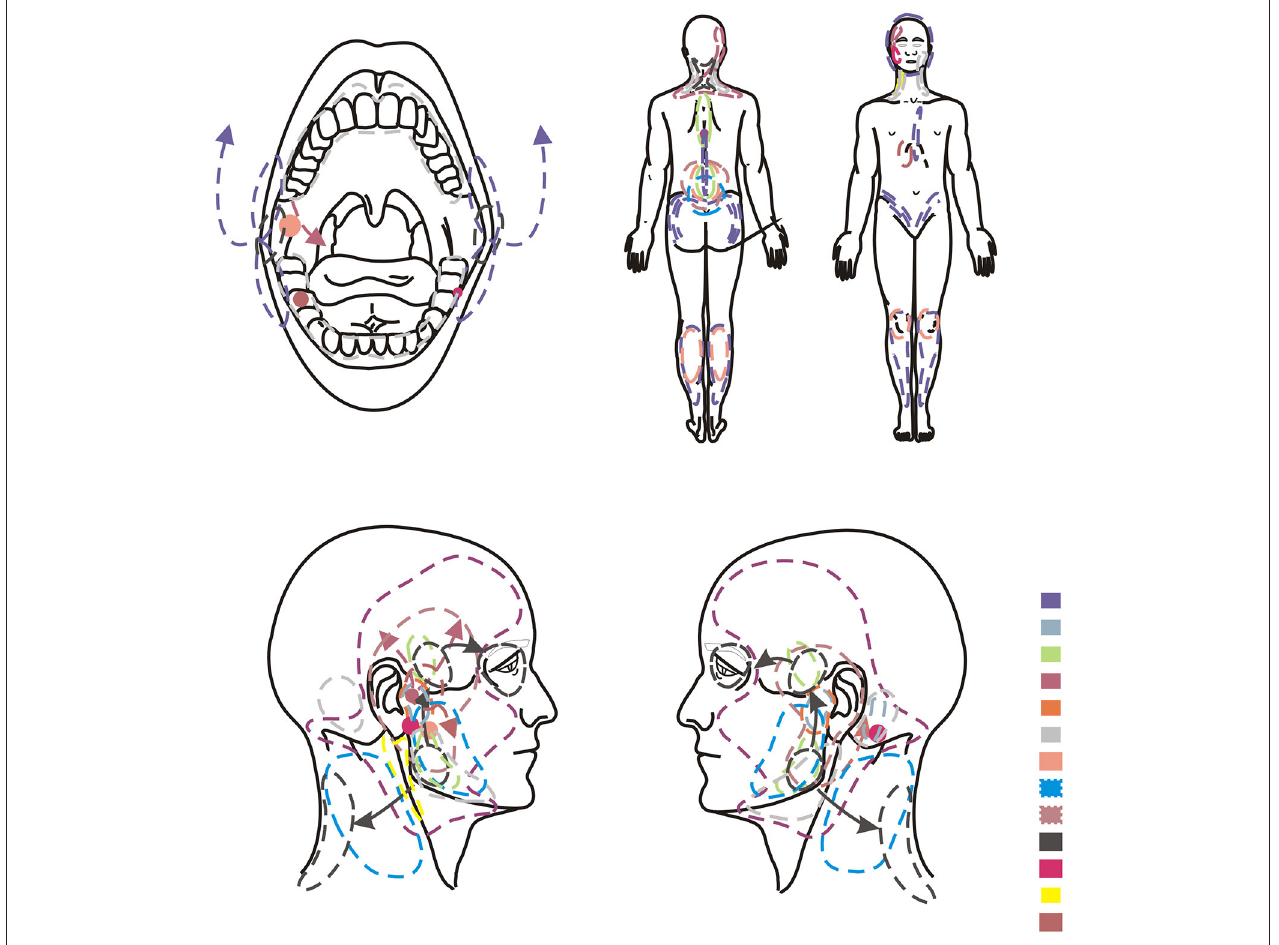
FIGURE 2 | Orofacial and general pain location in group of men ( n = 13).